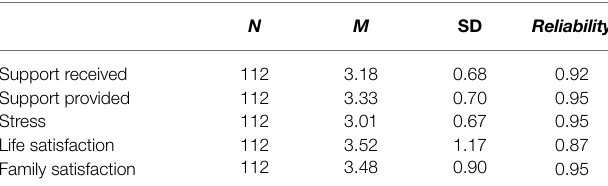
TABLE 2 | Mean and standard deviation of social support received and provided, stress and life and family satisfaction.